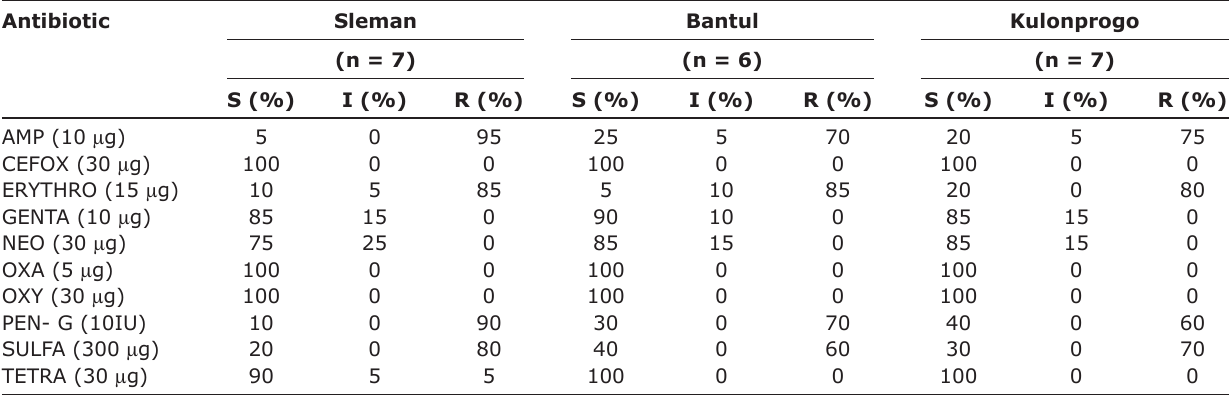
Table-4: Susceptibility of antibiotics against S. aureus from SCM in PE goats in Yogyakarta.